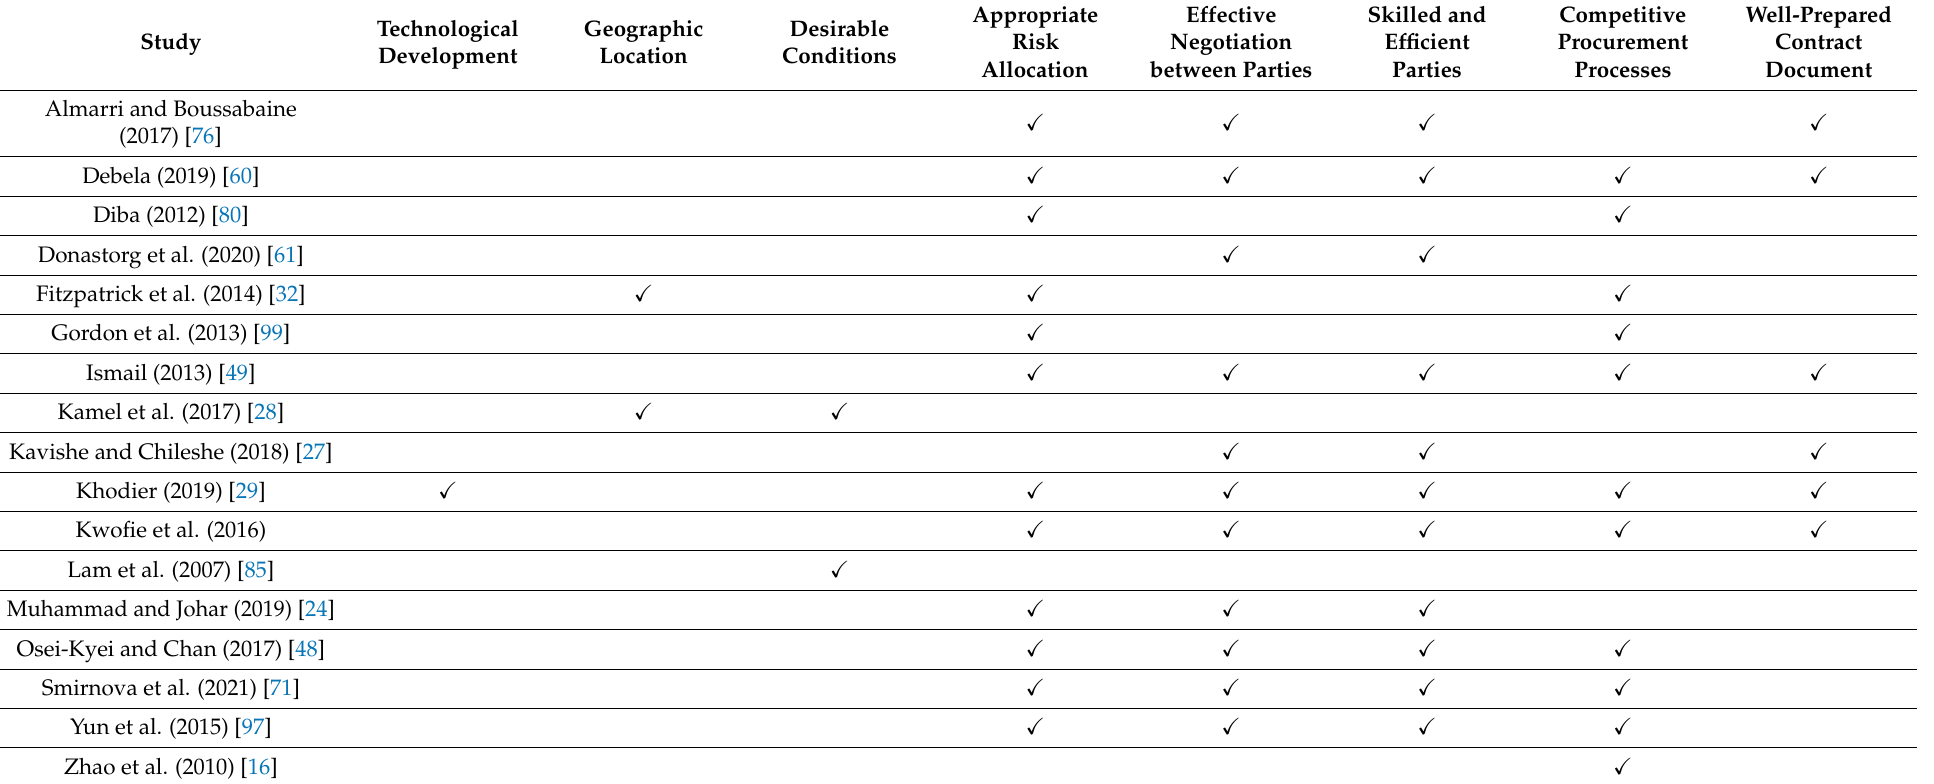
Table A3. Key success factors investigated in the different studies in the